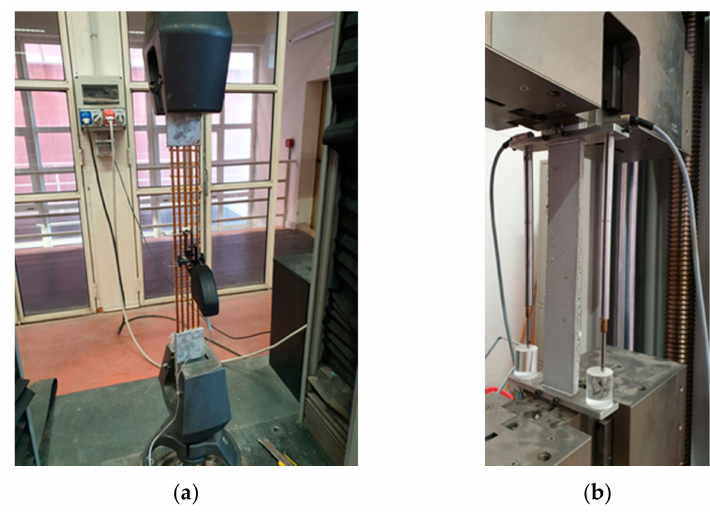
Figure 2. Test setup: ( a ) dry fabric and ( b ) FRCM specimen.